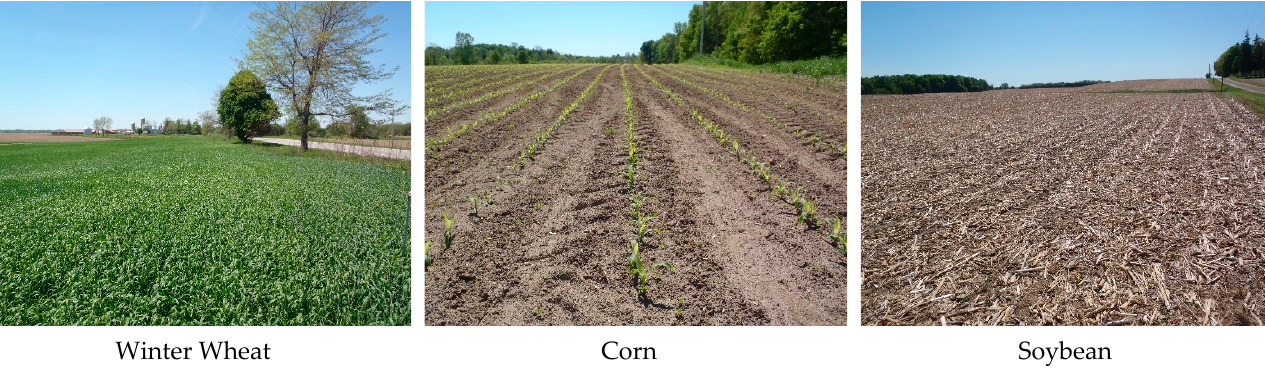
Figure 2. Field photos of three main crop types over the study site on selected acquisition dates. Top row, winter wheat; middle row, corn; bottom row, soybean. The grey boxes correspond to no photos taken due to crop fields in preparation, seeding or harvested time.